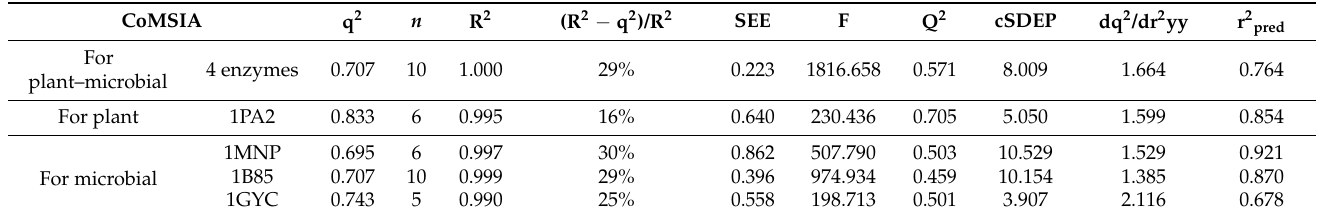
Table 2. Parameters of the CoMSIA model for the plant, microbial, and the plant–microbial synergistic degradation effects of QNs.